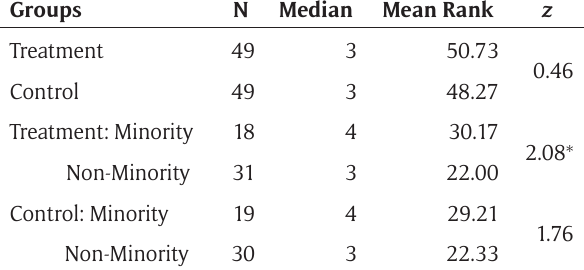
Table 2: Comparisons of groups on interest in finding out more about other citizen science projects. *p ≤ .05.